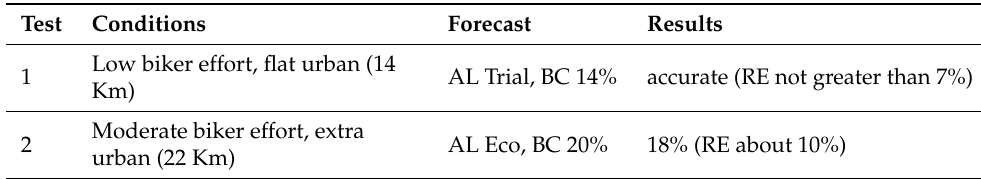
Table 2. First set summary with Specialized Turbo Vado 5.0 2020 (legend: AL is Assist Level, BC is Battery Consumption, RE is Relative Error).